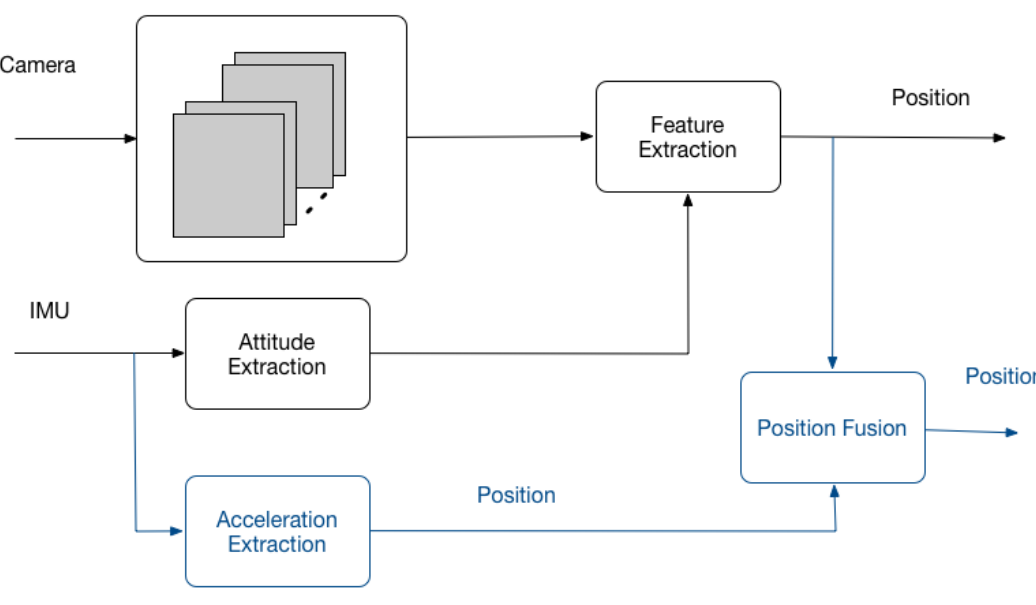
Figure 5. Flow diagram of Vision + IMU integration